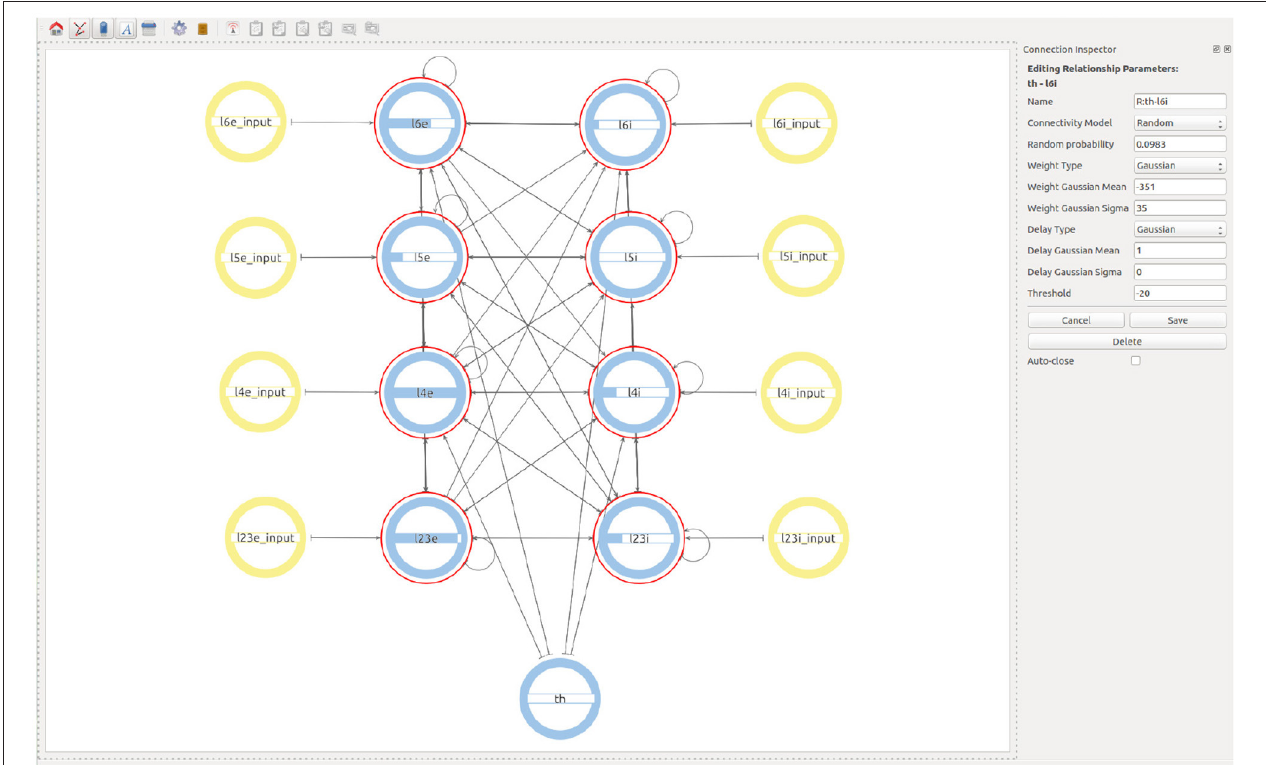
FIGURE 7 | Final view of the complete model considering all populations, connections, and input